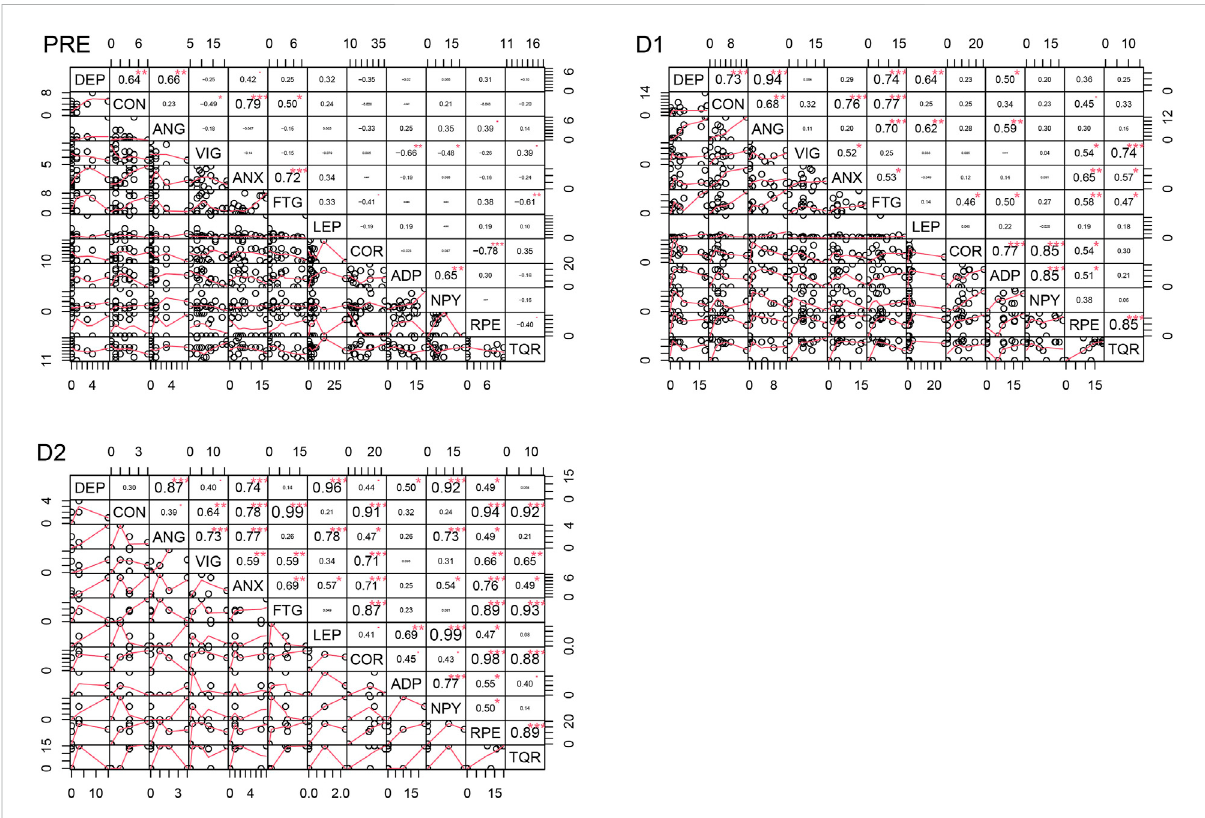
FIGURE 4 Correlation analyses for thenon- fi nisher group atthe four time points. DEP =Depression, CON= Confusion,ANG = Anger, VIG =Vigor,ANX = Tension-ANXiety, FTG = Fatigue, LEP = Leptin, COR = Cortisol, ADP = Adiponectin, NPY = Neuropeptide Y, RPE = Ratings of Perceived Exertion, TQR = Total Quality of